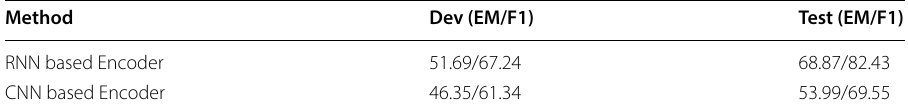
Table 1 Result of our experiment. It means that the RNN based Encoder gives better performance than using CNN based